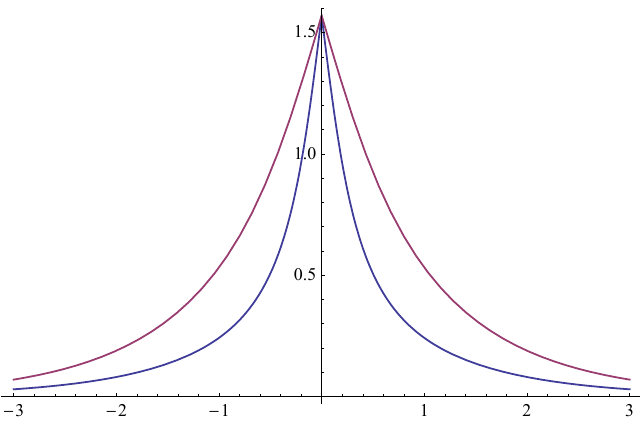
Figure 3 . The soliton (3.24) of the Heisenberg model with a sine-Gordon potential. The colours correspond to: A=0.1 for blue and A=10 for purple. βφ π/ 2 at the origin, corresponding to x = x 0 .